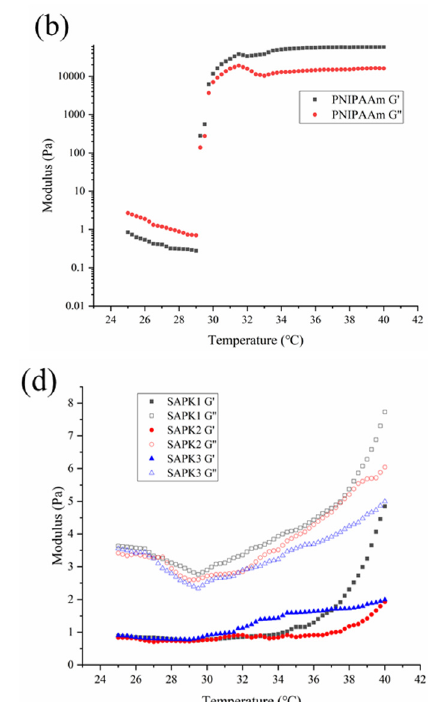
12 of 19 Figure 7. pH ‐ dependent swelling behaviors of beads with different compositions. 3.4. Rheological Properties The rheological properties of the samples were investigated by monitoring the storage modulus (G’) and loss modulus (G’’) as a function of temperature (Figure 8). The G’’ values were obviously larger than the corresponding G’ values within the temperature range of 25–40 °C (Figure 8a), showing typical liquid viscosity behavior, and the storage and loss moduli gradually decreased with the temperature for the SA formulation, which exhibited Arrhenius behavior [57]. Figure 8b indicates that there were two processes involved in the change of the G’ and G’’ of PNIPAAm as the temperature increased. In the first phase, viscoelastic properties exhibited an initial behavior governed by the Arrhenius law, where G’ and G’’ decreased with temperature. Then, the slope of modulus versus temperature became positive, which meant that the PNIPAAm hydrogels started to exhibit their hydrophobicity as a consequence of the conformational coil–globule transition related to the LCST. Furthermore, G’ increased faster than G’’, and G’ values became much larger than G’’, showing elastic behavior, concerning the sol–gel transition [58]. As is shown in Figure 8c,d, the modulus law of the aqueous samples containing PNIPAAm changed with temperature and was similar to that of PNIPAAm. First, the G’ and G’’ decreased as the temperature increased, and then it started to increase after reaching a critical temperature. The observed critical temperature was consistent with the previously characterized LCST results. However, within the temperature range of 25–40 °C, there was no case where G’ values were larger than G’’, which was due to the presence